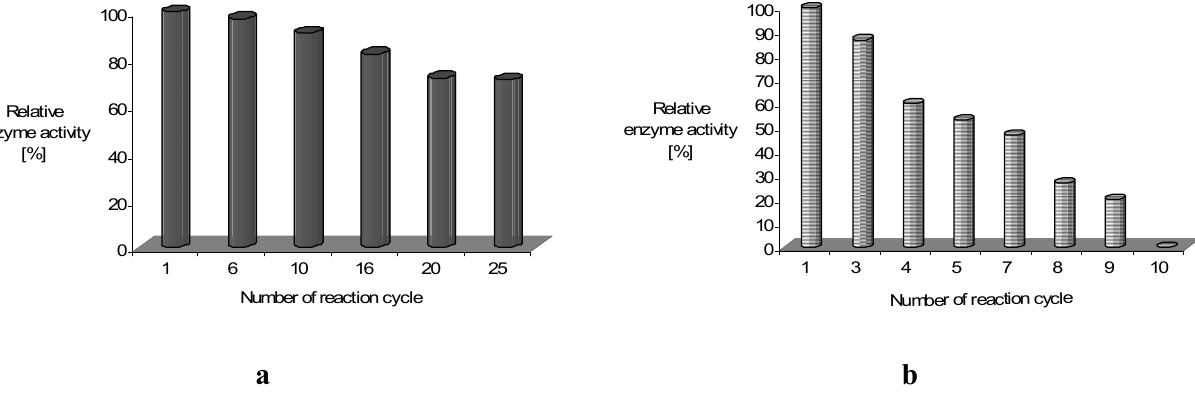
Figure 12. Immobilized laccase- a , and tyrosinase- b activity during repeated reaction cycle in presence of 2,2'-azino-bis(3-ethylbenzthiazoline-6-sulphonic acid)-ABTS as substrate (0.228 mM) [17].